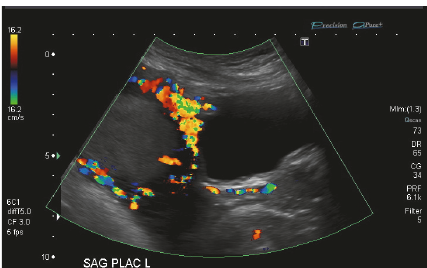
Figure 1: Doppler ultrasound in the sagittal plane at midline in the pelvis demonstrates turbulent peripheral vascularity in the placenta extending across the myometrium to the posterior wall of the bladder. The bladder contour is otherwise smooth; however, the finding remains highly suggestive of placenta percreta. No defect in the uterine wall could be identified, but given the large volume of hemorrhagic ascites, an emergency diagnostic laparoscopy was subsequently